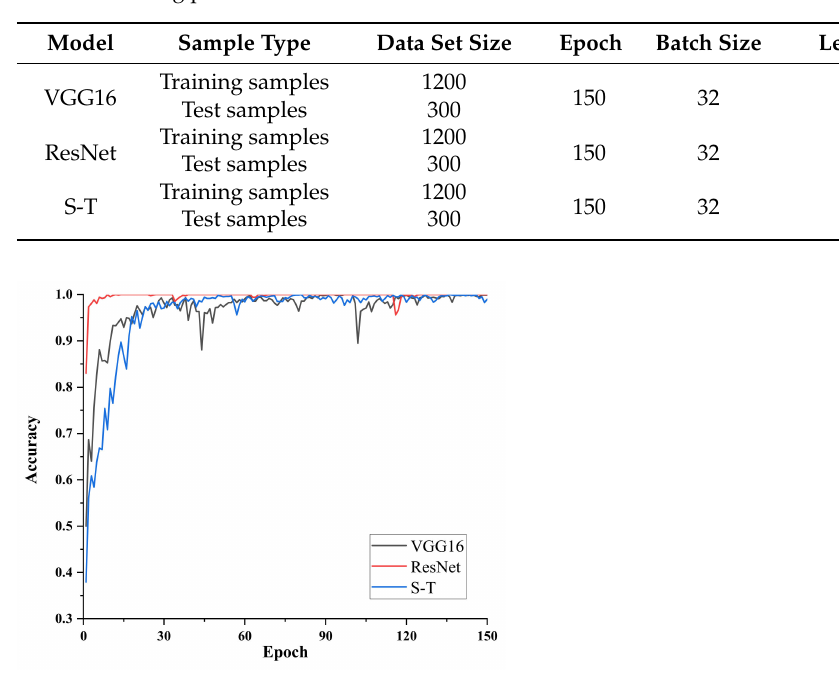
Figure 4. Accuracy change curve of each model training set.